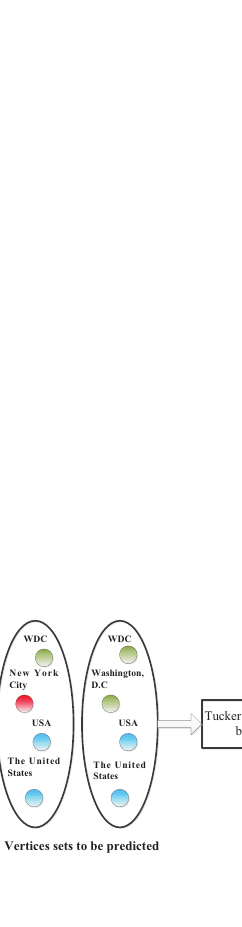
Figure 2. A sketch of TF-DHP directed hypergraph prediction model. The embedding of entity sets to be predicted are fed into the Tucker-decomposition-based layer to calculate the score. The target of model training is to make the score of existing hyperlinks larger than the score of entities set without hyperlinks. Then, the embeddings of entities in the existing hyperlink are sent to the BiLSTM layer to calculate the direction score. The target of model training is to make the score in the positive direction larger than the score in the negative